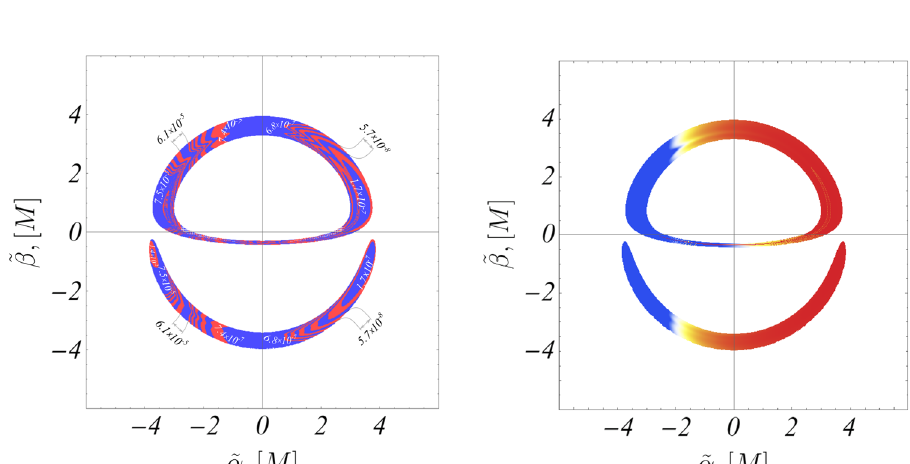
Fig. 20 Contour plot of the apparent radiation flux for the outer disk of the strongly naked singularity with γ = 0 . 48 (left) and the Schwarzschild black hole (right). The observer is located at r obs = 5000 M , and at the inclination angle i = 80 ◦ . The observable flux is normalized by the maximal value of the radial flux distribution for each solution Fig. 21 Continuous distribution of the apparent radiation flux for the strongly naked singularity with γ = 0 . 48 (left) and the Schwarzschild black hole (right). The observer is located at r obs = 5000 M , and at the inclination angle i = 80 ◦